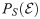
The relationship between PS(E) (left panel) and Zipf plots (E versus log-rank, right panel).As in Fig 4, ε increases downward on the y-axis in panels B and D. A and B. We bypassed an explicit latent variable model, and set P(E)=Uniform(E;0,30)/2+δ(E-15)/2. The deviation from Zipf’s law, shown as a blip around E=15, is small. This is general: as we show in Methods Peaks in P(E) do not disrupt Zipf’s law, departures from Zipf’s law scale as 1/n even for large delta-function perturbations. C and D. We again bypassed an explicit latent variable model, and set P(E)=Uniform(E;0,10)/2+Uniform(E;20,30)/2. The resulting hole between E=10 and 20 causes a large deviation from Zipf’s law.